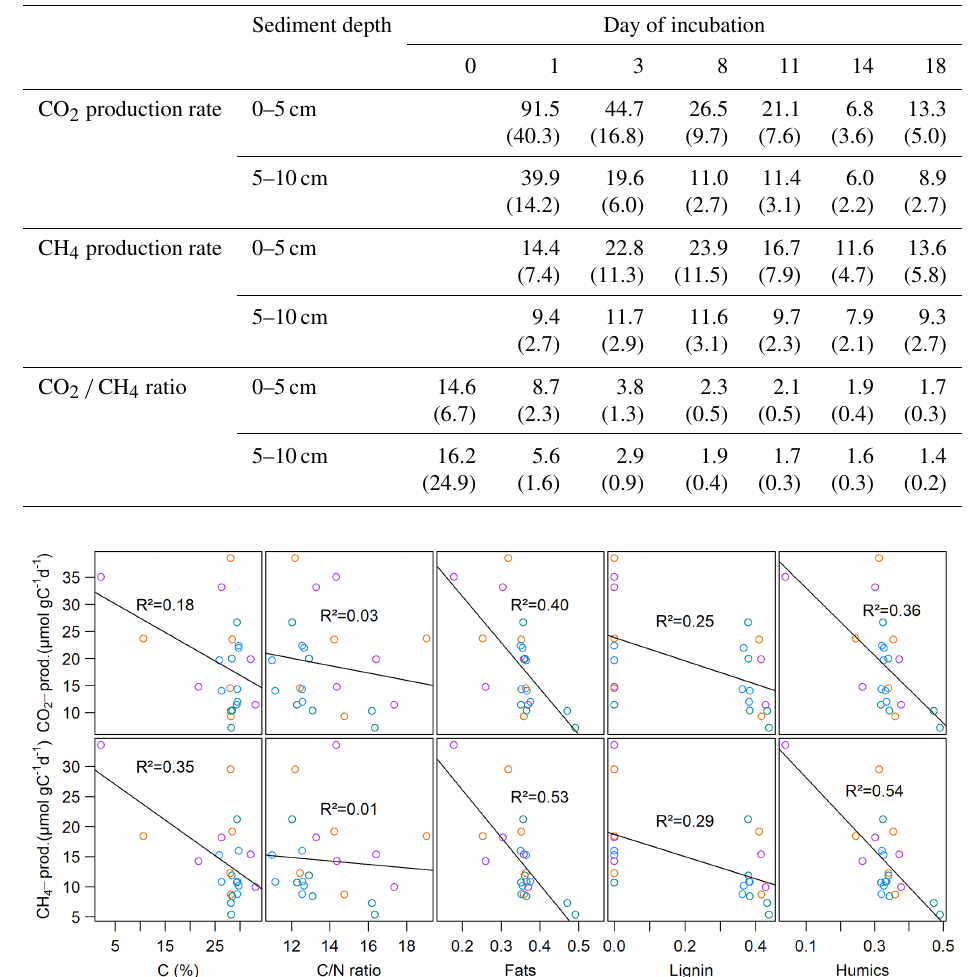
Figure 5. Correlations between CO 2 and CH 4 production rates and OM quality parameters as determined by elemental analysis or FTIR spectroscopy. Different colors denote different depth categories (see Fig.